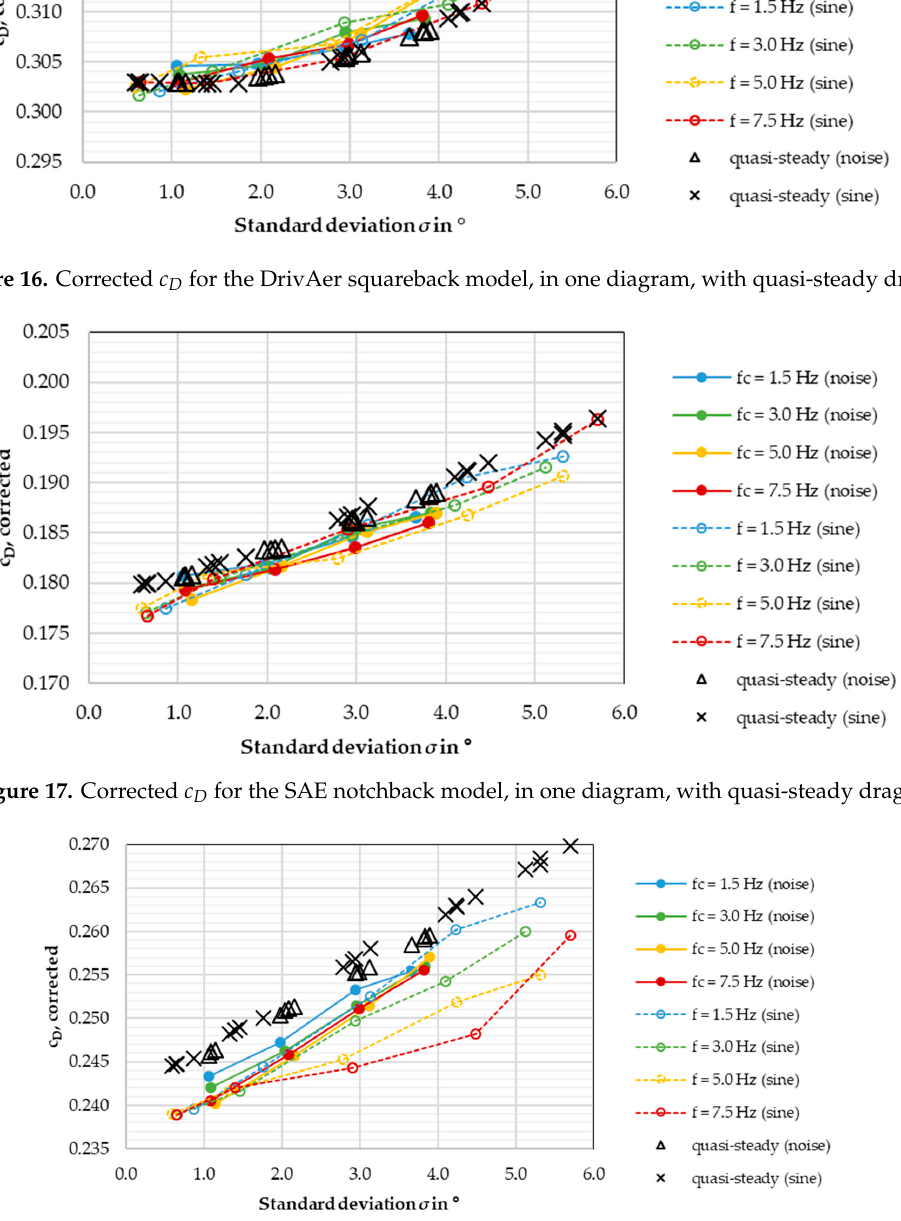
Figure 18. Corrected c D for the SAE squareback model, in one diagram, with quasi-steady Figure 18. Corrected 𝑐 (cid:3005) for the SAE squareback model, in one diagram, with quasi-steady drag. Figure 18. Corrected 𝑐 (cid:3005) for the SAE squareback model, in one diagram, with quasi-steady drag. Figure 18. Corrected 𝑐 (cid:3005) for the SAE squareback model, in one diagram, with quasi-steady drag.